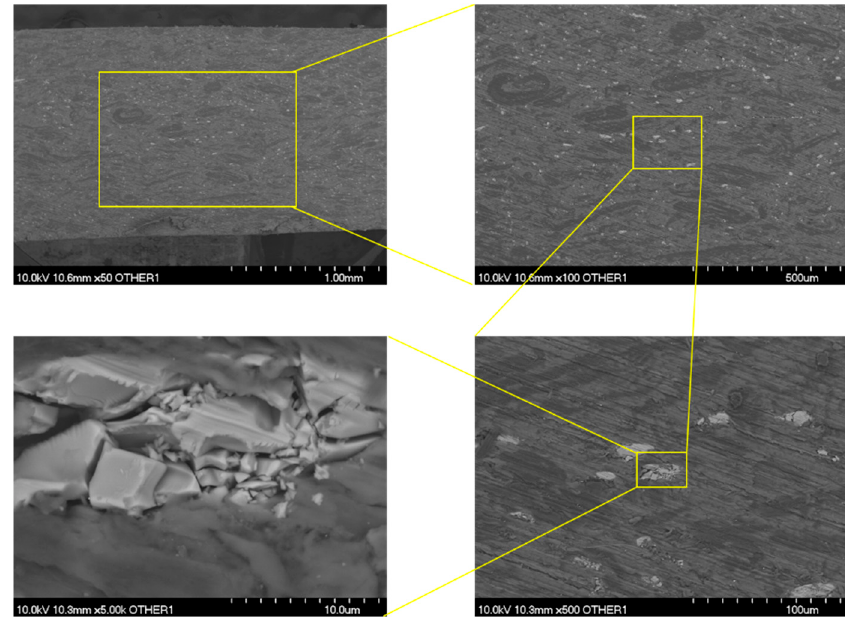
Figure 5. SEM images showing a multi-phase structure of the as-received sample.